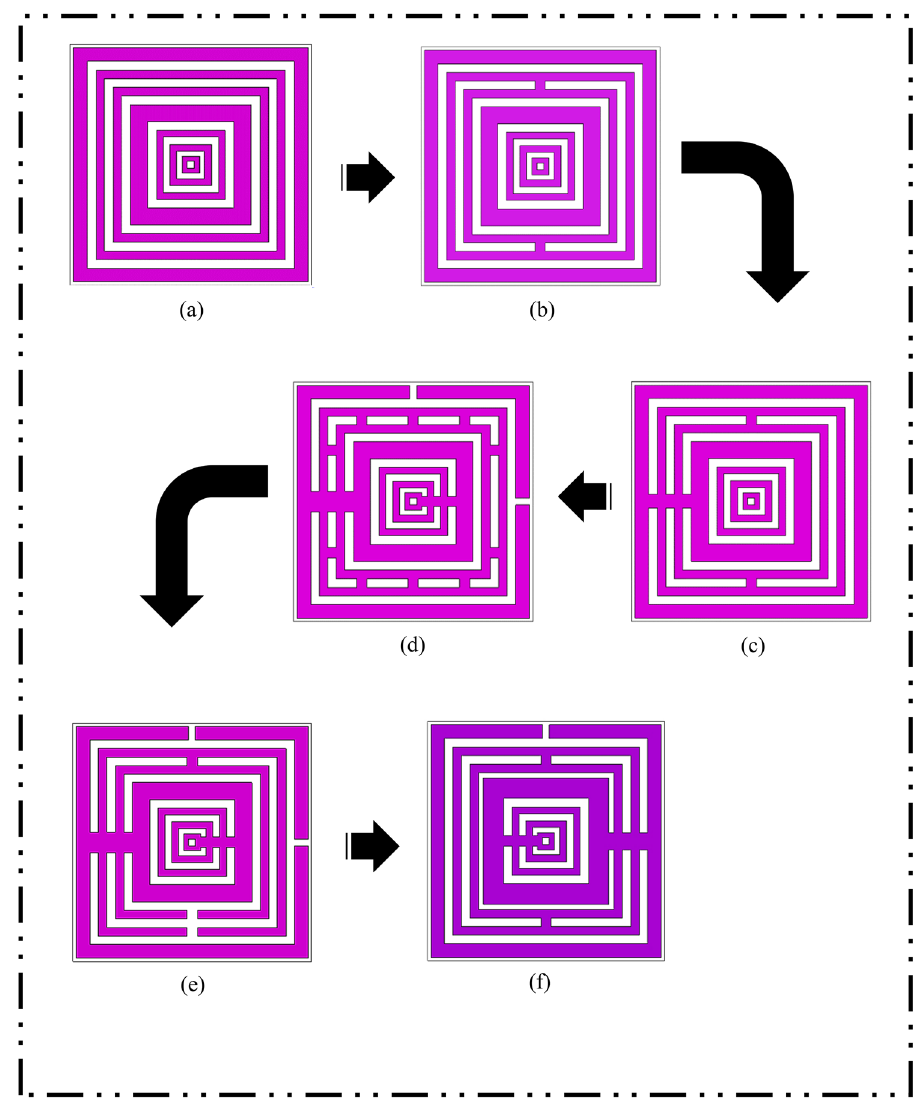
Figure 5. Various square-shaped metamaterial structures: ( a ) DS 1, ( b ) DS 2, ( c ) DS 3, ( d ) DS 4, ( e ) DS 5, ( f ) SM